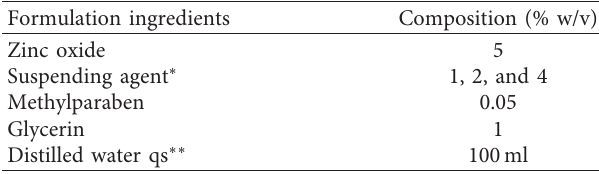
Table 1: Formulation ingredients of the zinc oxide suspensions. Formulation